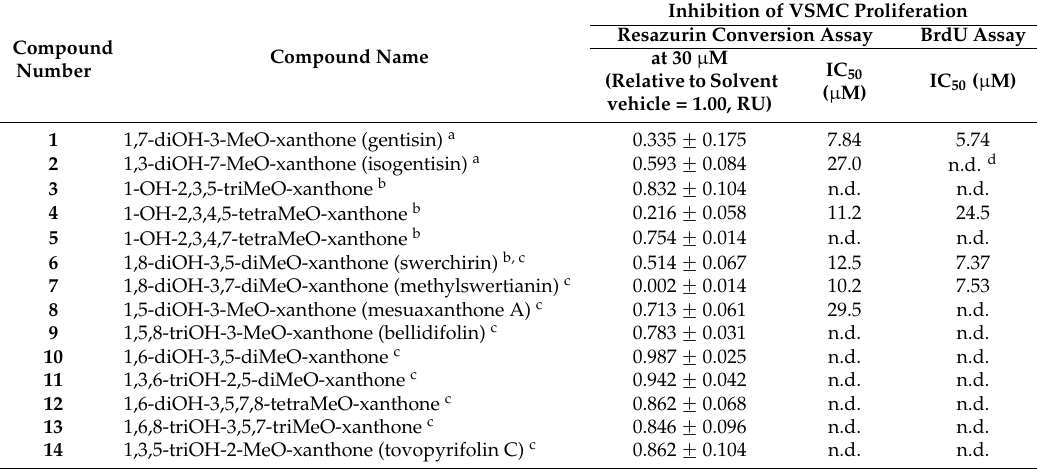
Table 1. Inhibition of VSMC proliferation by compounds 1 – 14 in the resazurin conversion and in the BrdU incorporation assays. Data (means ˘ SD, n = 3) are presented as relative units (RU) in comparison to the control (cells treated with PDGF in the presence of 0.1% DMSO vehicle; 1.00 RU) or IC 50